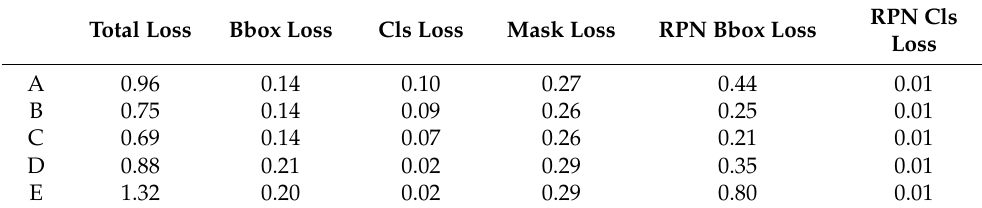
Table 2. Loss comparison of the network models under different anchor scales.